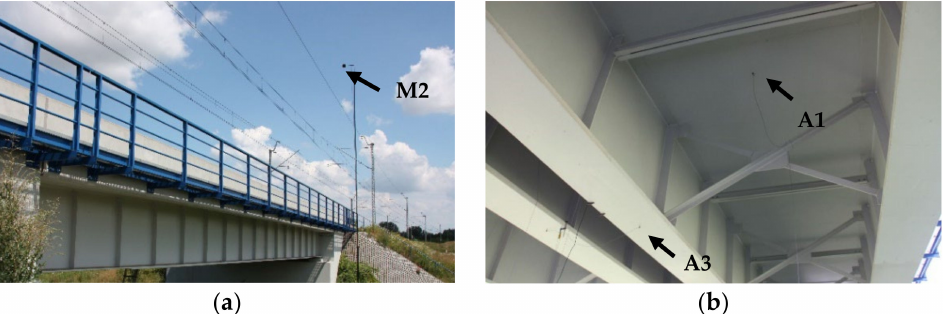
Figure 3. Measurements points: ( a ) microphone at point M2, ( b ) accelerometers mounted on the deck (m.p. A1) and the bottom flange of the girder (m.p.